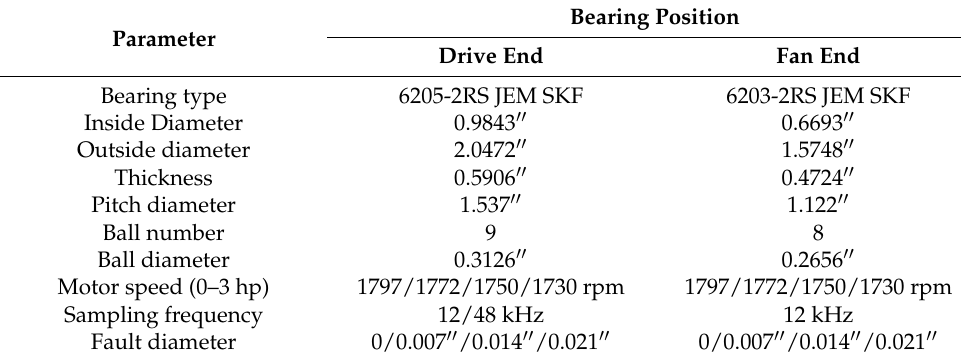
Table 1. CWRU test device and data description.